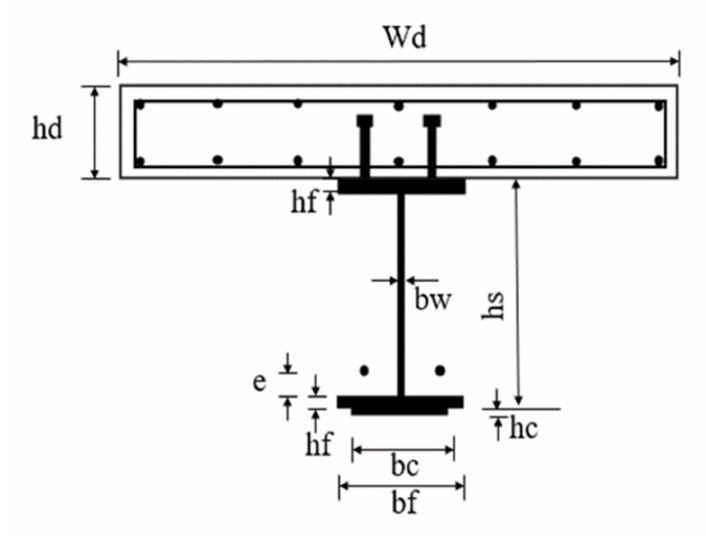
Figure 3. Details and dimensions of the validated beams. Table 1. Dimensions of the cross-sections of the validated beams.